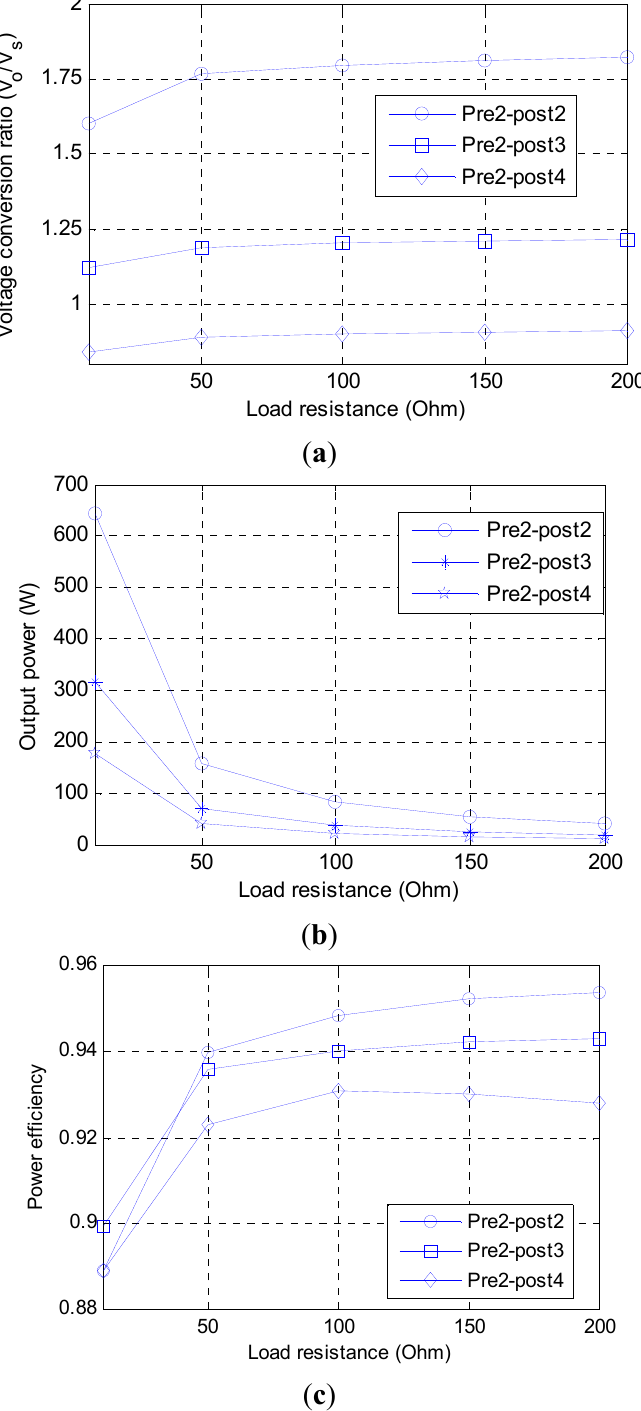
Figure 8. The output power, voltage conversion ratio and power efficiency versus load resistor of n = 2 to pre-stage, m = 2, 3, 4 to post-stage: ( a ) voltage conversion ratio versus load resistor; ( b ) output power versus load resistor; and ( c ) the power efficiency versus output